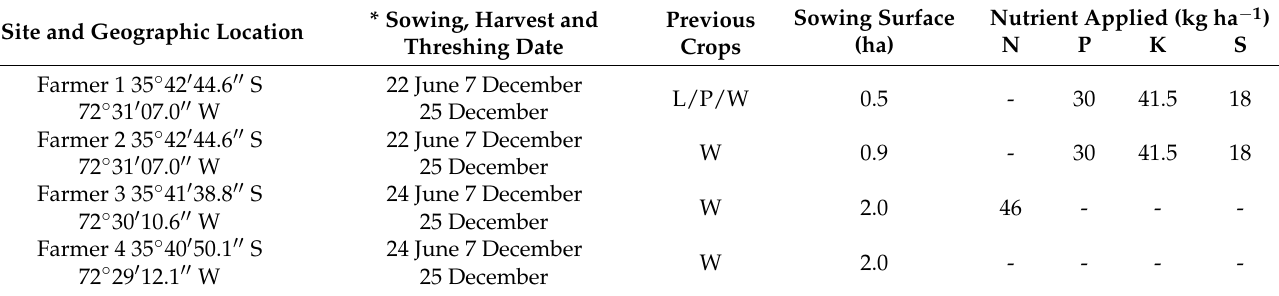
Table 1. Agronomic management conducted by four lentil farmers and their geographical locations in the town of Chanco, Maule region, central